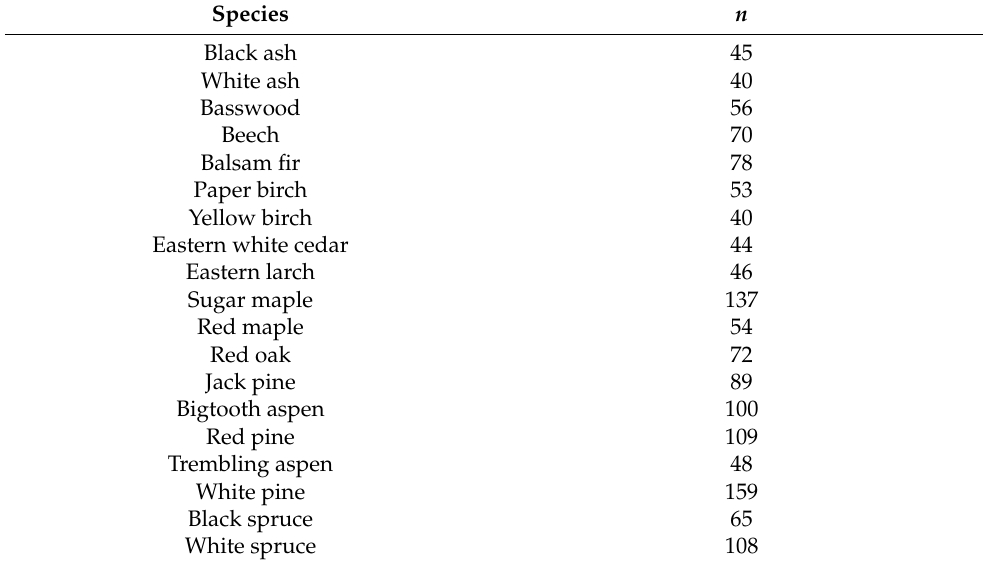
Table 4. Number of training crowns per species ALS12 ( n = 1413).